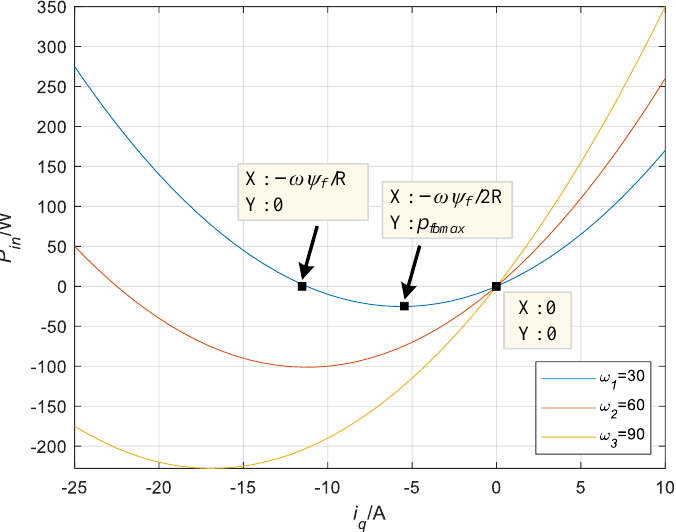
Figure 4. The input power function diagram of PMSM at various ω values ( ψ f = 0.3 Wb, R = 0.8 Ω ).